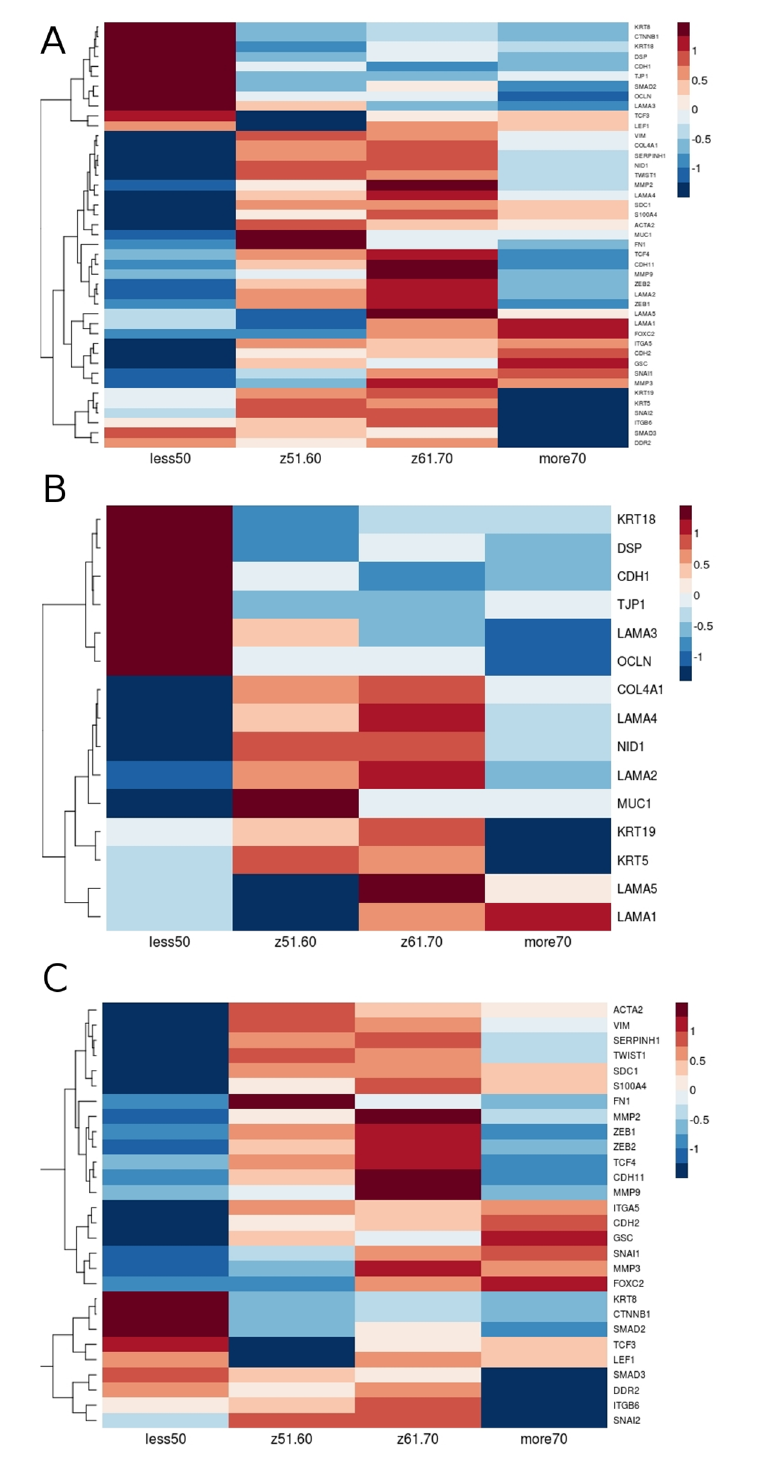
Fig 6. The same Gleason score differs in age groups in expression of EMT markers. The profilesof EMT markers are distinct between age groups within the same Gleason score (A). Differential expressionof epithelial(B) vs mesenchymal (C) markers in age groups within the same Gleason score.